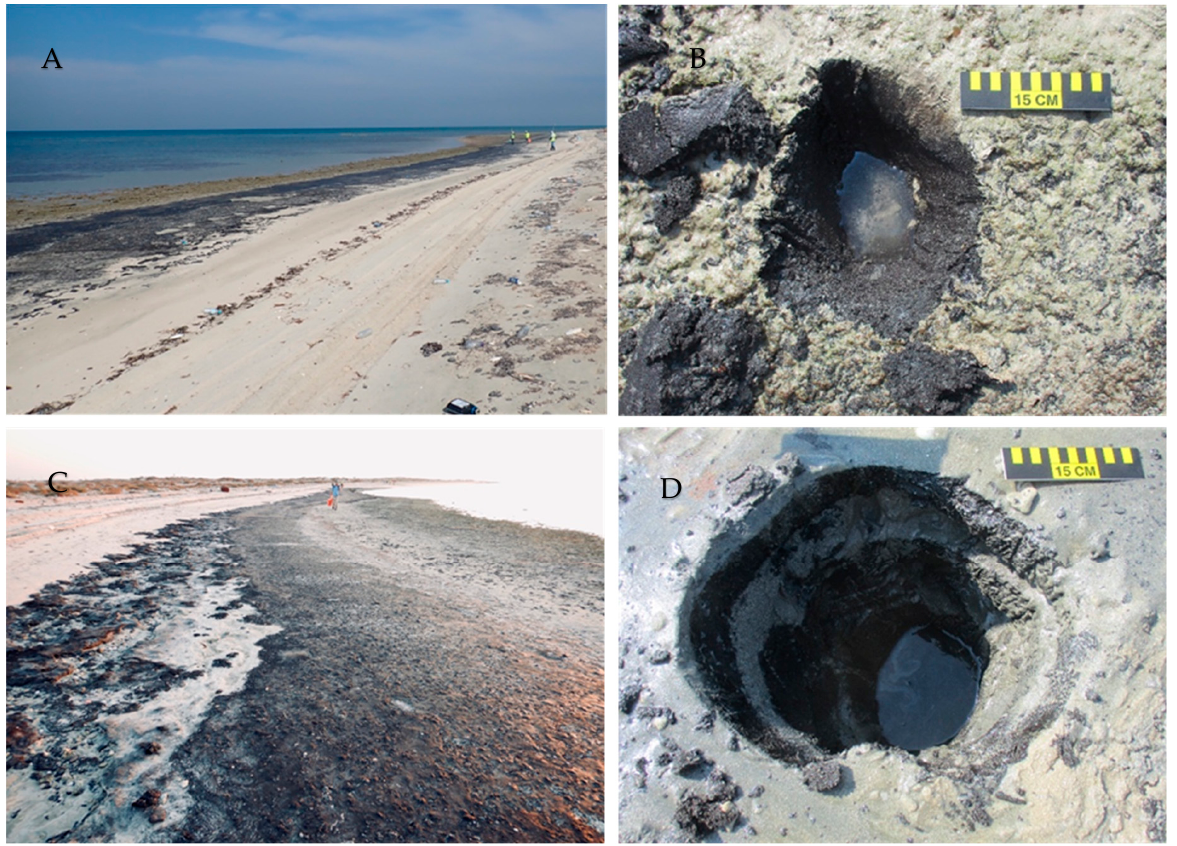
Figure 3. Example photographs of continuous asphalt pavement and heavily oiled sediments exposed in the lower intertidal zone on beach rock ( A ), middle intertidal zone on sand ( B ), pits excavated in the exposed asphalt pavement ( C ), and heavily oiled sediment layers below asphalt pavement ( D ) along Abu Ali Island in 2020.